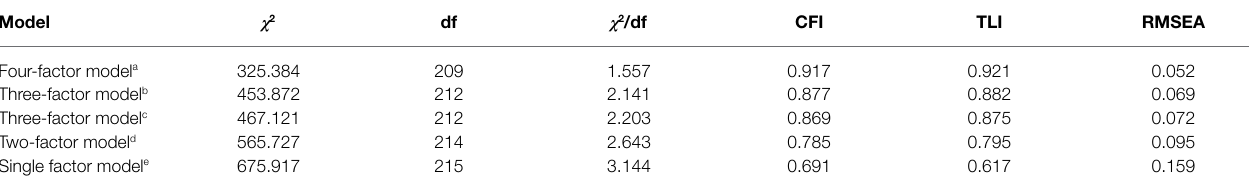
TABLE 2 | Confirmatory factor analyses